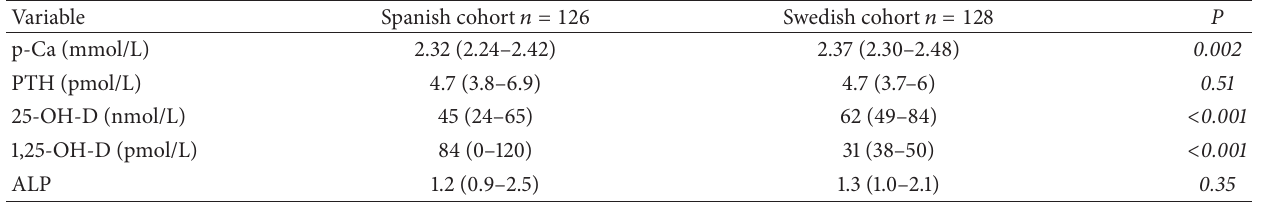
Table 2: Biochemical variables one year after surgery for primary hyperparathyroidism.